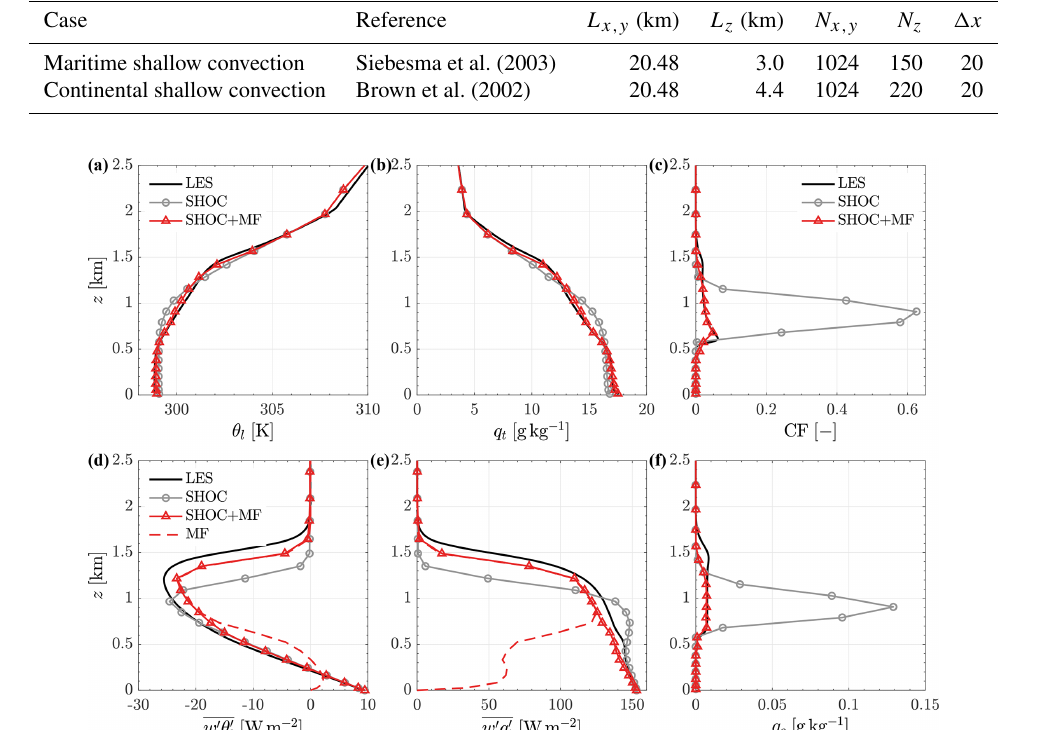
Table 1. Summary of the cases simulated. The details of each case setup are described in the references (second column). Here, L x,y and L z are the horizontal and vertical domain lengths, N x,y and N z are the number of horizontal and vertical grid points, and (cid:49)x is the grid spacing.